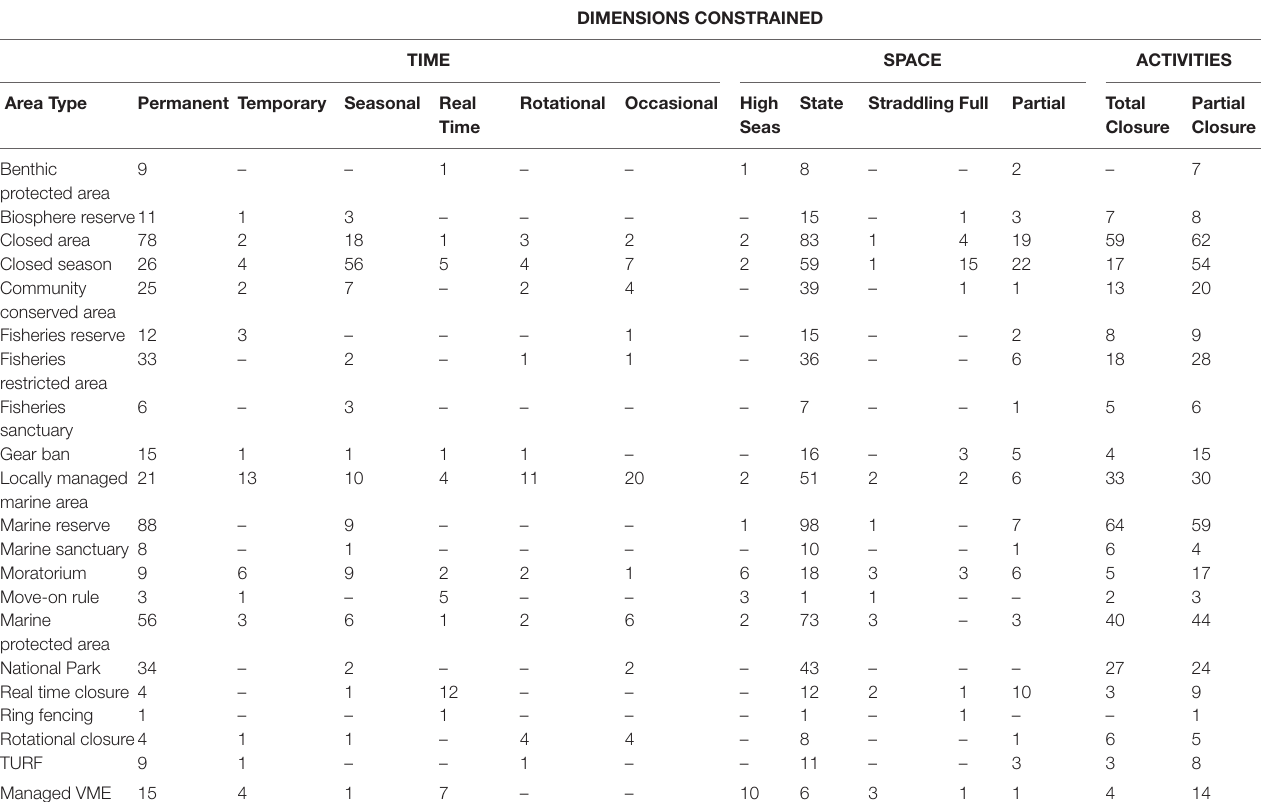
TABLE 2 | Categories of fisheries ABMTs characterized by their constraints in time, space and allowed